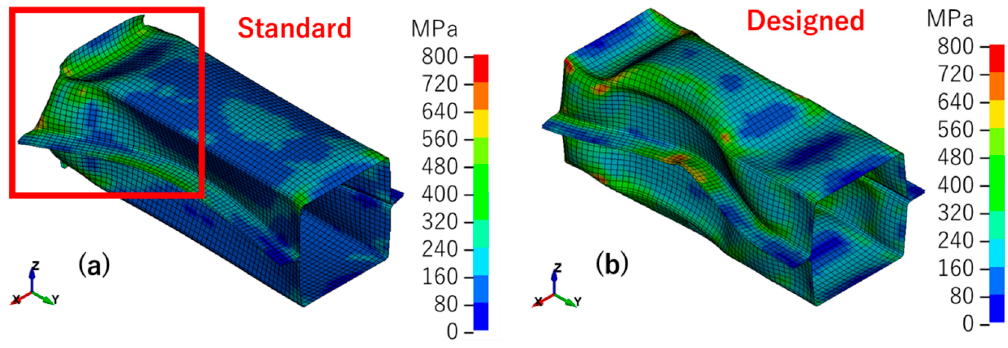
Figure 10. Von Mises effective stress: ( a ) standard model; ( b ) designed model.